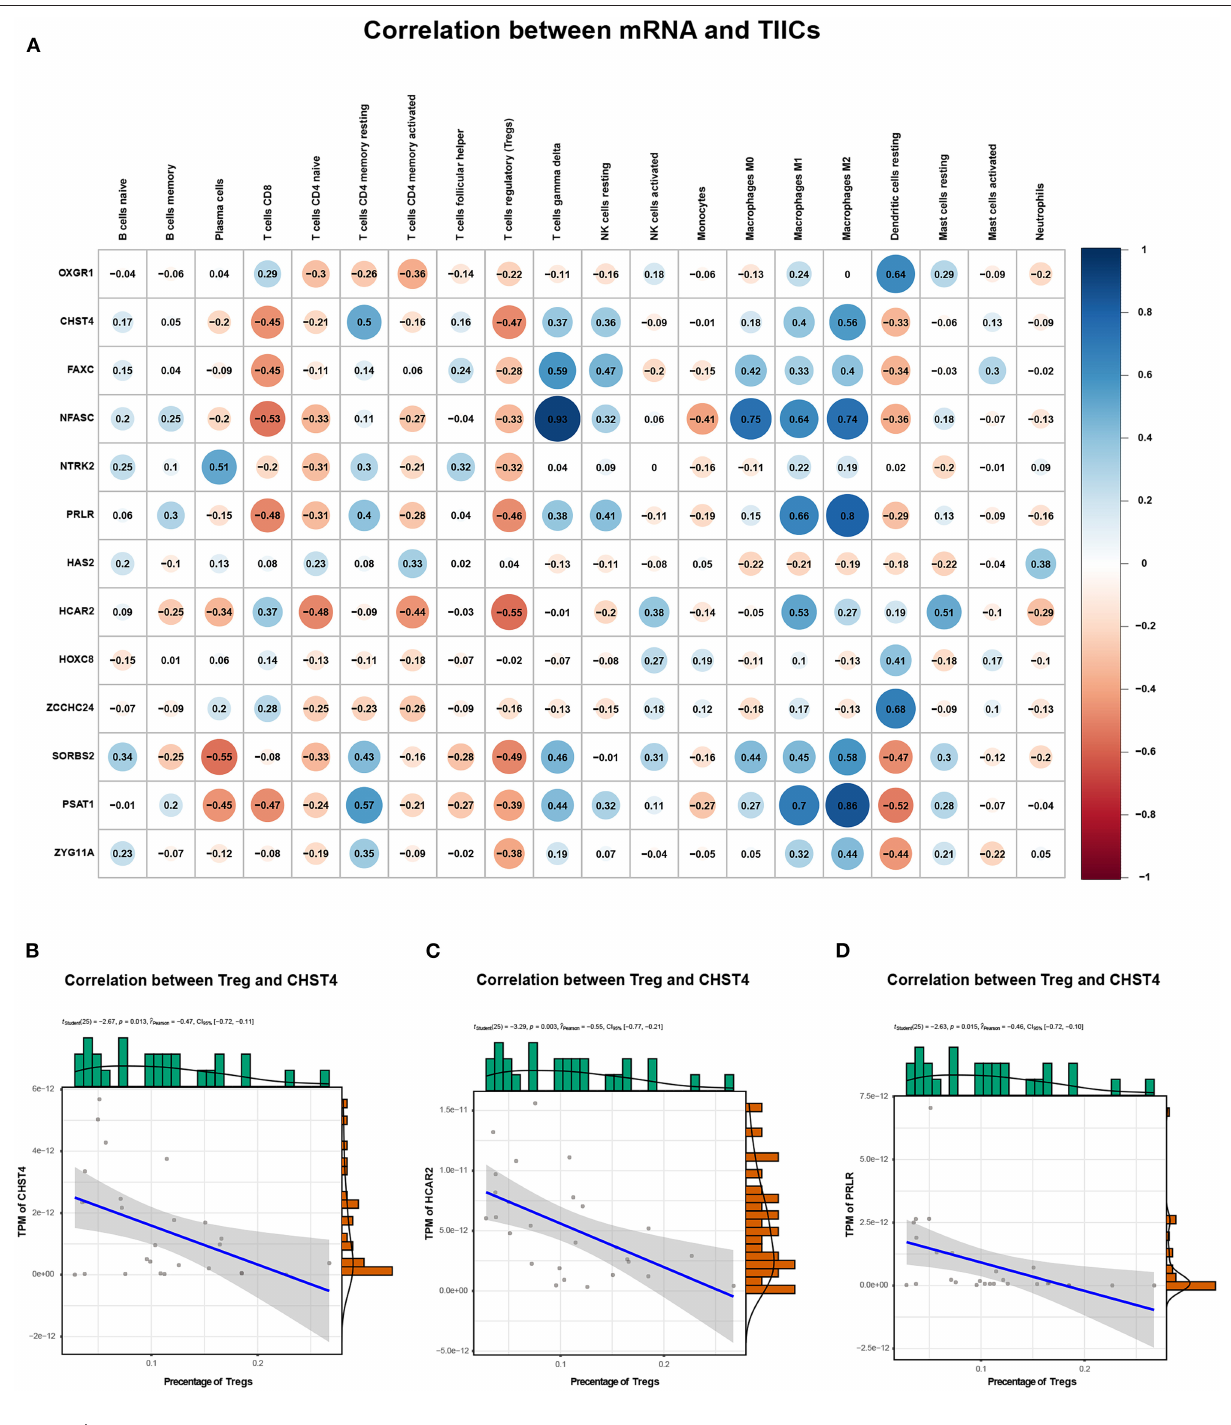
FIGURE 5 | Correlation between mRNAs in the ceRNA network and estimated immune cells. (A) shows the Pearson correlation coefficient between mRNAs in the ceRNA network and immune cells. (B) illustrates the correlation between CHST4 and Tregs ( r = − 0.47, p = 1.312 × 10 − 2 ); (C) shows the correlation between HCAR2 and Tregs ( r = − 0.55, p = 2.956 × 10 − 3 ); (D) shows the correlation between PRLR and Tregs ( r = − 0.47, p = 1.457 × 10 − 2 ). In (B–D) , the blue line represents a linear mode indicating the relationship between mRNA expression (TPM value) and the percentage of Tregs (the gray area represents the 95% confidence